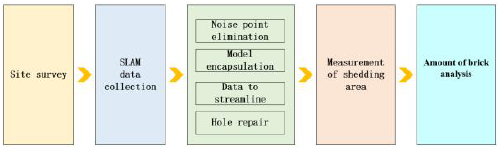
Figure 3. the technical road map for the main content